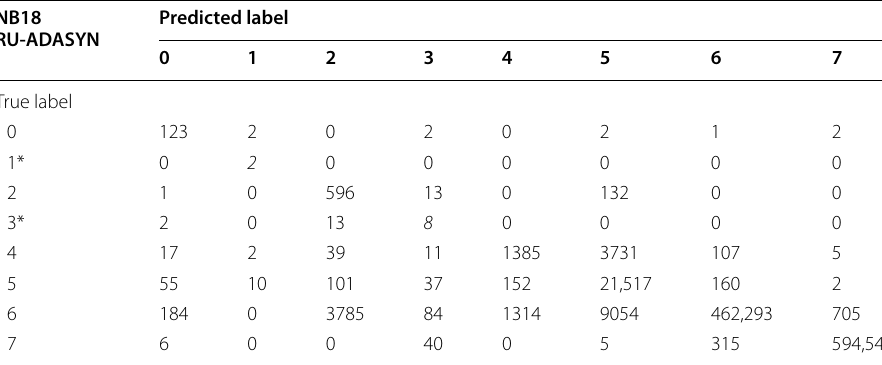
Table 36 Confusion Matrix: NB18 RU-ADAYSN NB18